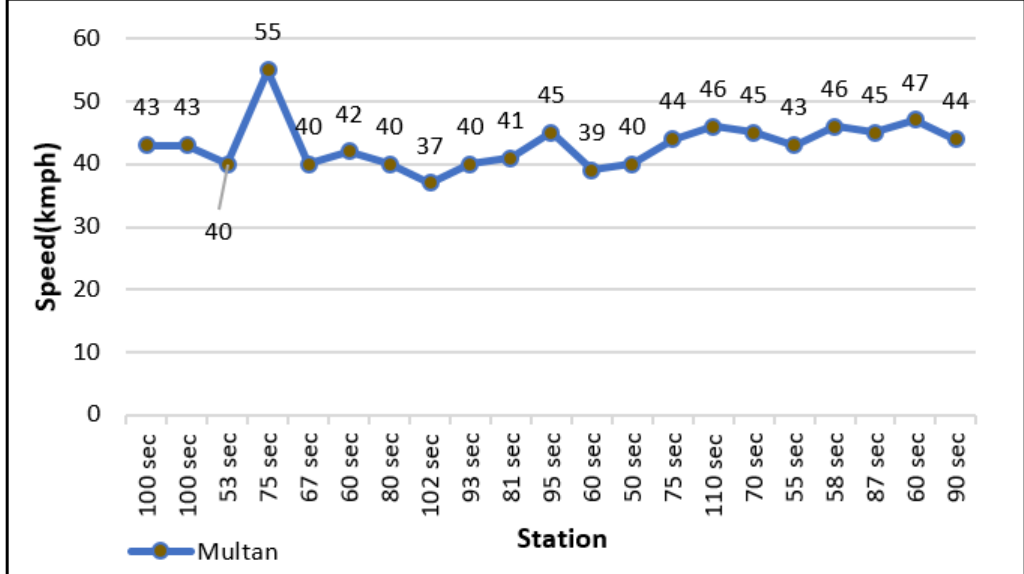
Figure 6. Analysis of Travel Speed of Multan with Respect to Time